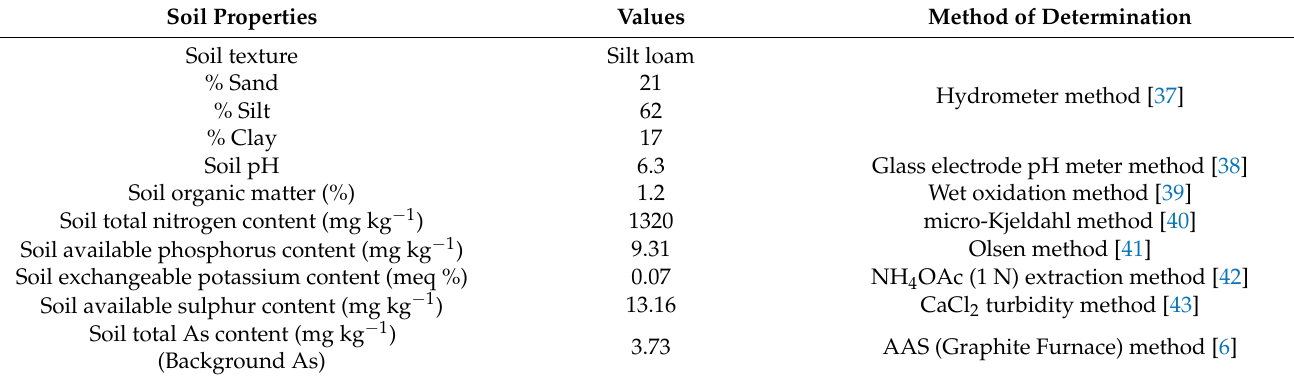
Table 1. Physicochemical properties of soil with their methods of